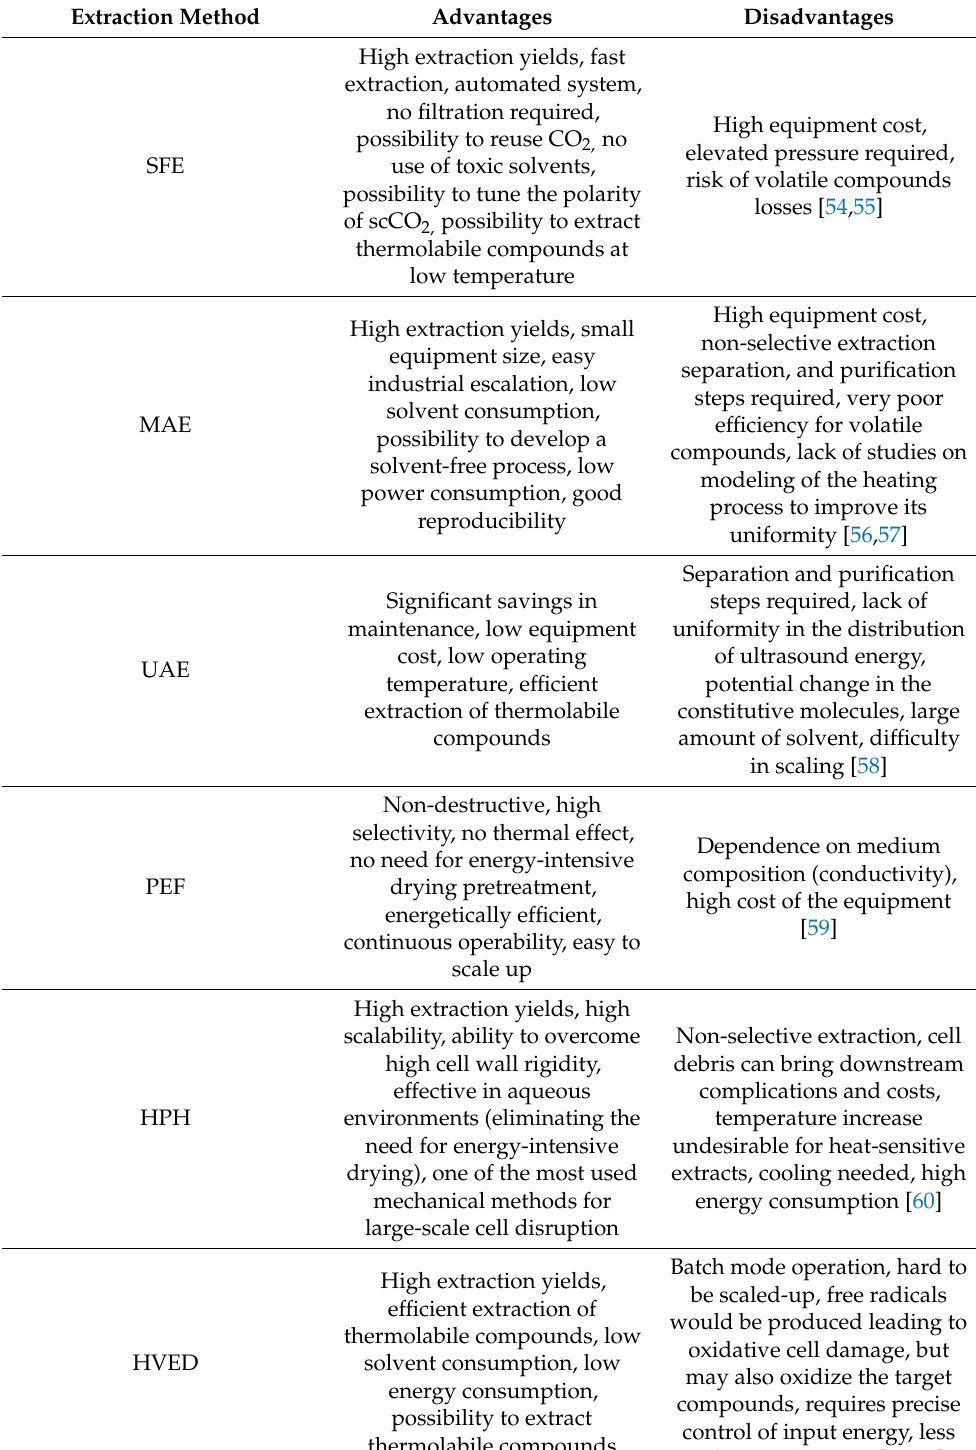
Table 3. Advantages and disadvantages of green extraction